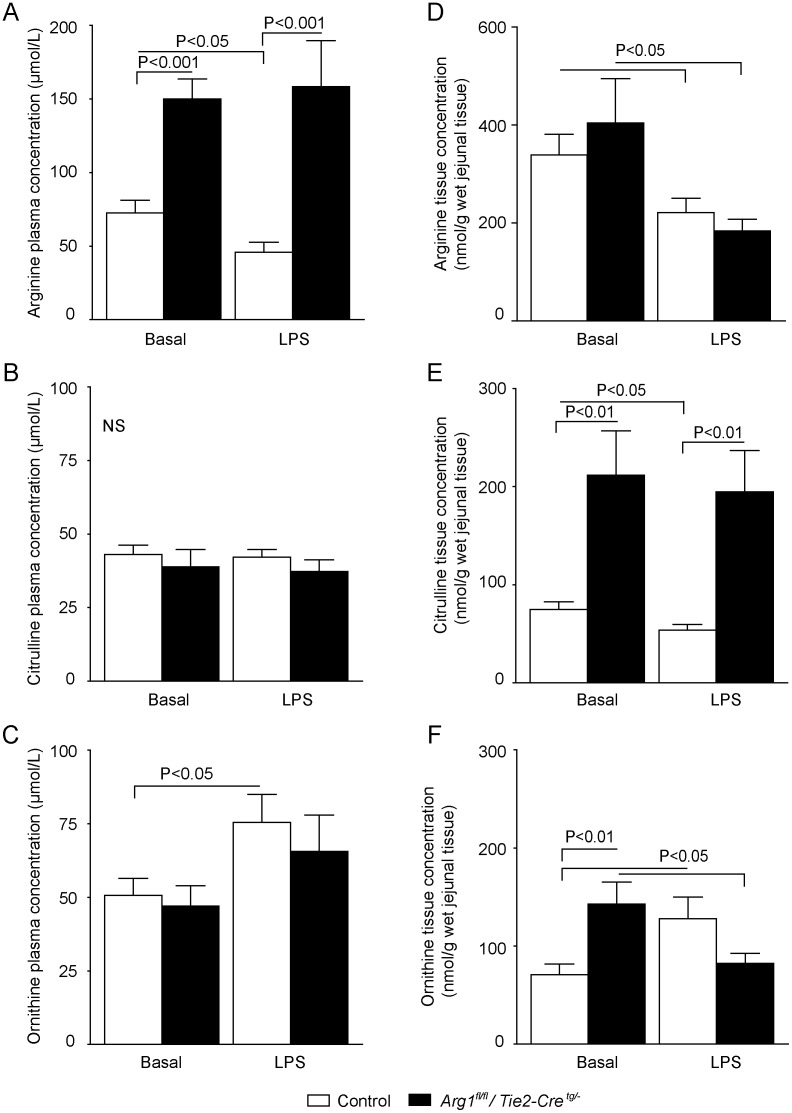
Plasma and tissue arginine, citrulline and ornithine concentrations in control and Arg1fl/fl/Tie2-Cretg/− mice under basal and endotoxemic conditions.(A) Arg1fl/fl/Tie2-Cretg/− mice had a ∼2-fold higher plasma arginine concentration than control mice (control and control + LPS), which was not affected by LPS infusion (Arg1fl/fl/Tie2-Cretg/− + LPS). Plasma arginine concentration was significantly reduced in the control + LPS group compared to basal condition (P<0.05). (B) Plasma citrulline concentration was similar in control and Arg1fl/fl/Tie2-Cretg/− mice under both basal and inflammatory conditions. (C) Compared to the basal condition, plasma ornithine concentration only significantly increased in the LPS-treated control group, but not the Arg1fl/fl/Tie2-Cretg/− group. (D) Tissue arginine concentration declined ∼2-fold in LPS-treated groups compared to controls (P<0.05). (E) Tissue citrulline concentration was significantly higher in Arg1fl/fl/Tie2-Cretg/− than control mice under basal and endotoxemic conditions (P<0.01). LPS infusion reduced citrulline concentration in control (P<0.05), but not in Arg1fl/fl/Tie2-Cretg/− mice. (F) Under basal conditions, tissue ornithine concentration was higher in Arg1fl/fl/Tie2-Cretg/− than control mice. After LPS infusion, ornithine concentration increased in control mice (P<0.05), but decreased in Arg1fl/fl/Tie2-Cretg/− mice.